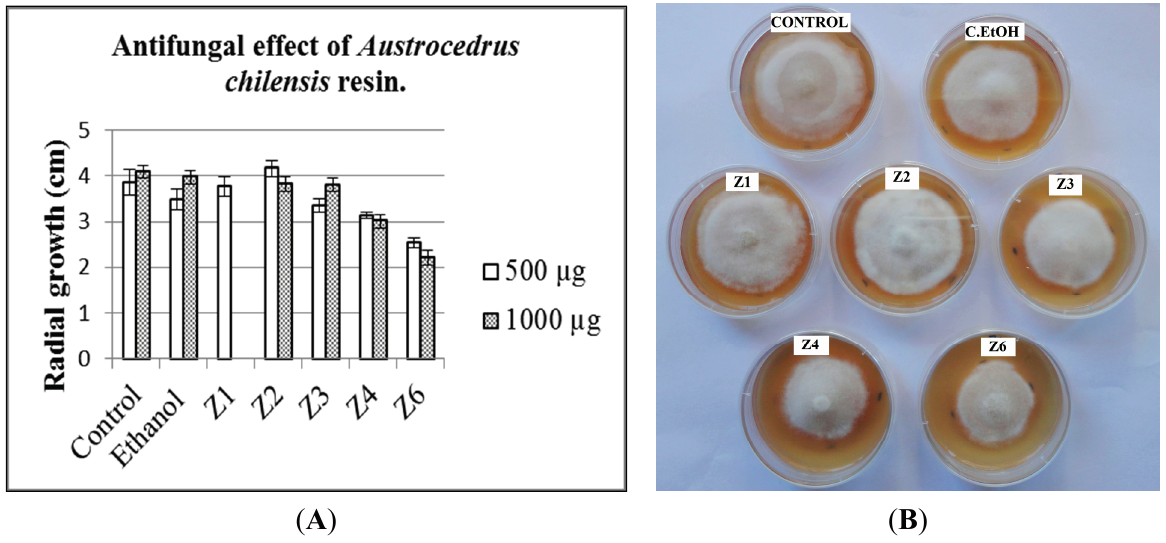
Figure 2. Antifungal effect of A. chilensis resin on P. austrocedri . ( A ) Graphic of the radial growth in agar dishes; ( B ) Growth inhibition assays for fungal growth. 500 µg of each fraction were distributed in the dish giving a concentration of 17.68 µg sample/cm 2 . The controls are presented in the top of the image. Control: Untreated P. austrocedri ; C. EtOH: Ethanol control. Z1–Z6: Tested resin